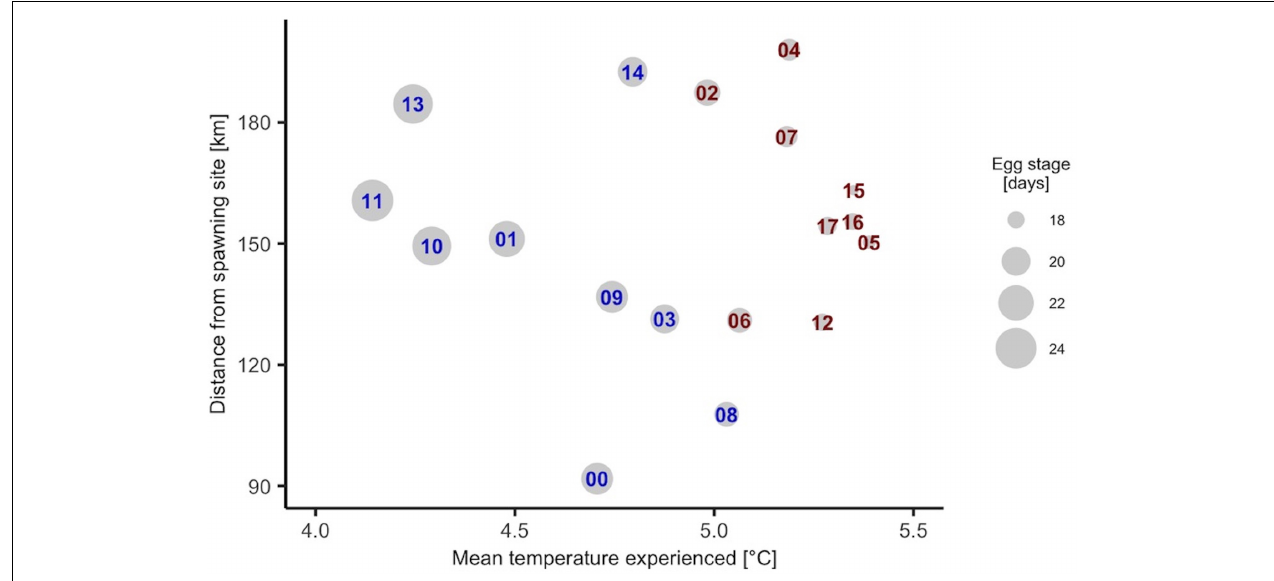
FIGURE 3 | Annual mean net distance from spawning sites to positions of eggs or larvae thirty days after spawning and corresponding ambient temperatures along the drift routes. Note that these values are weighted according to the temporal and spatial spawning intensity (see Materials and Methods). The size of the circles represents the yearly mean egg stage duration, while the numbers denote the year in the simulation period. Years in red and blue denote warm and normal, respectively.